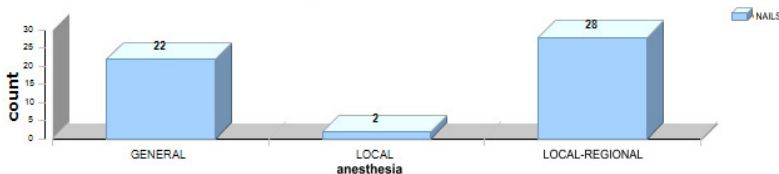
Figure 9: Results for query C’={NAILS ENDER